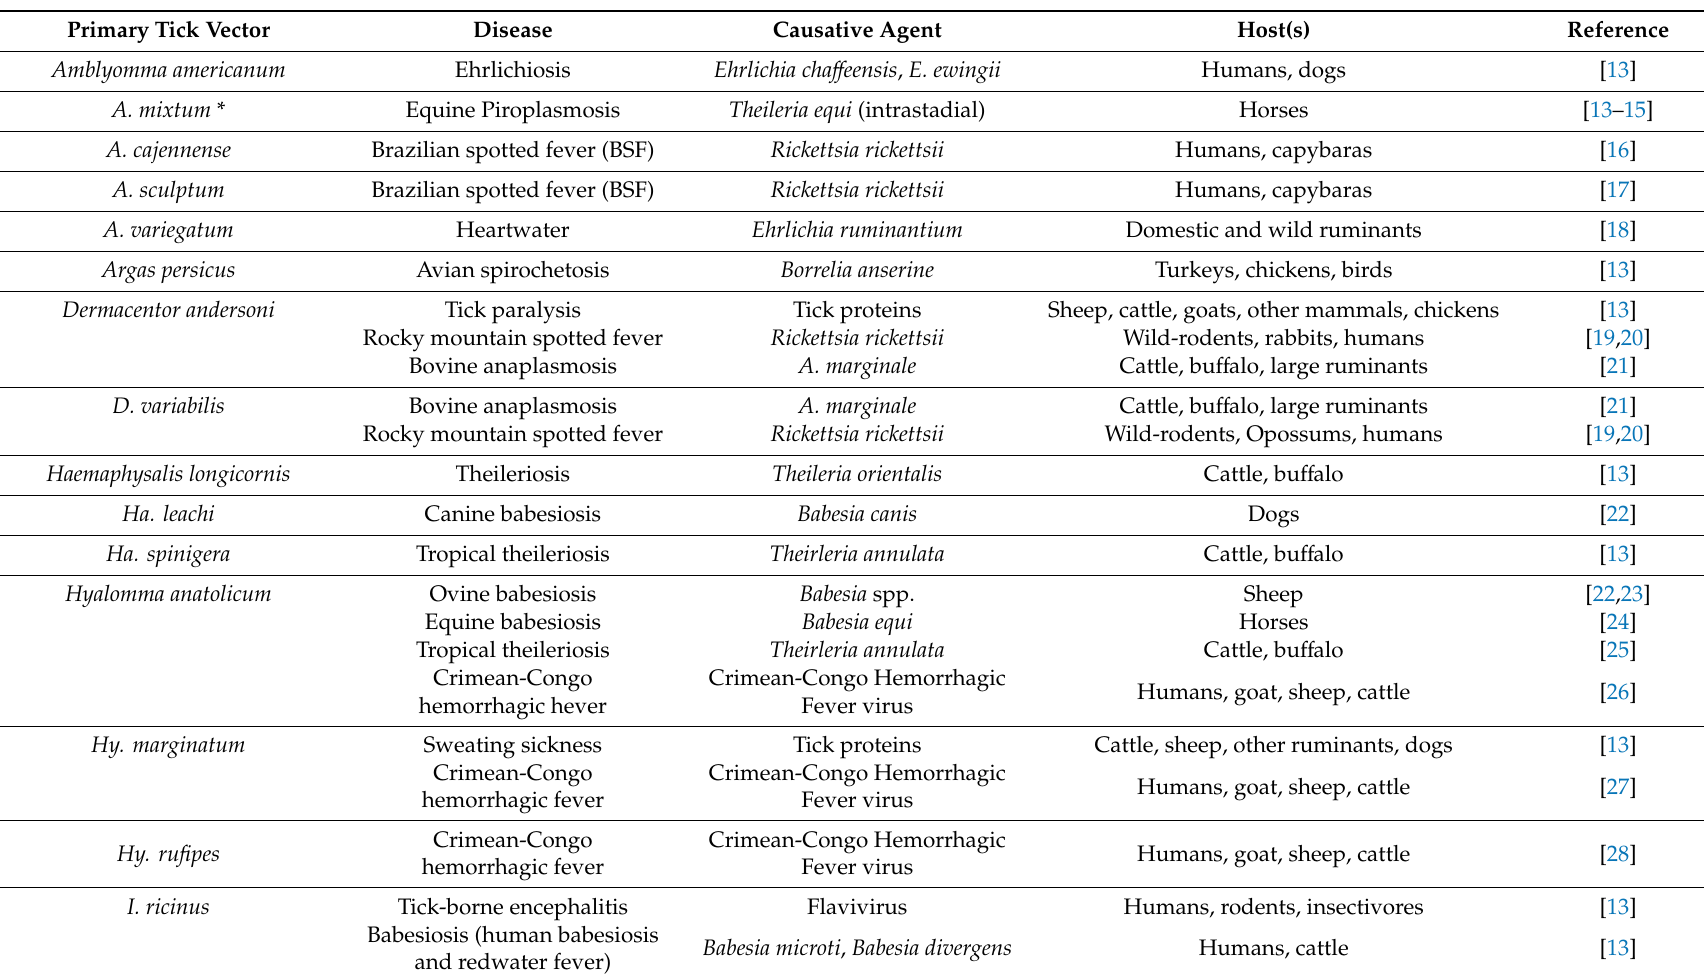
Table 1. Representative ticks and associated tick-borne diseases of human, livestock, and wildlife, and their causative agents and